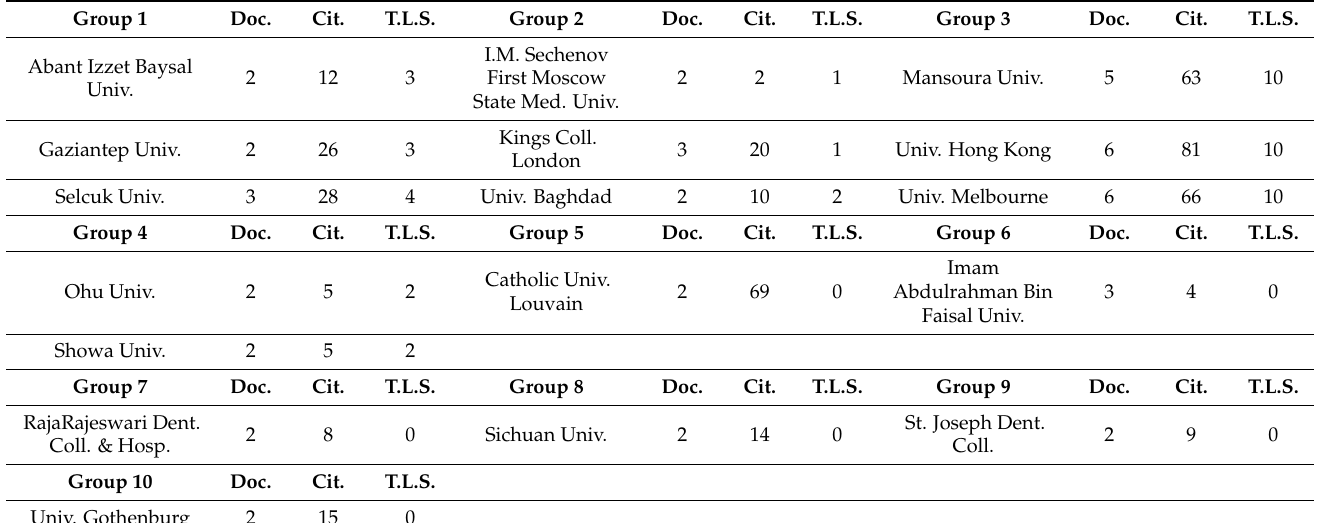
Table 4. Published documents grouped by university. Source: own processing through VOSviewer.